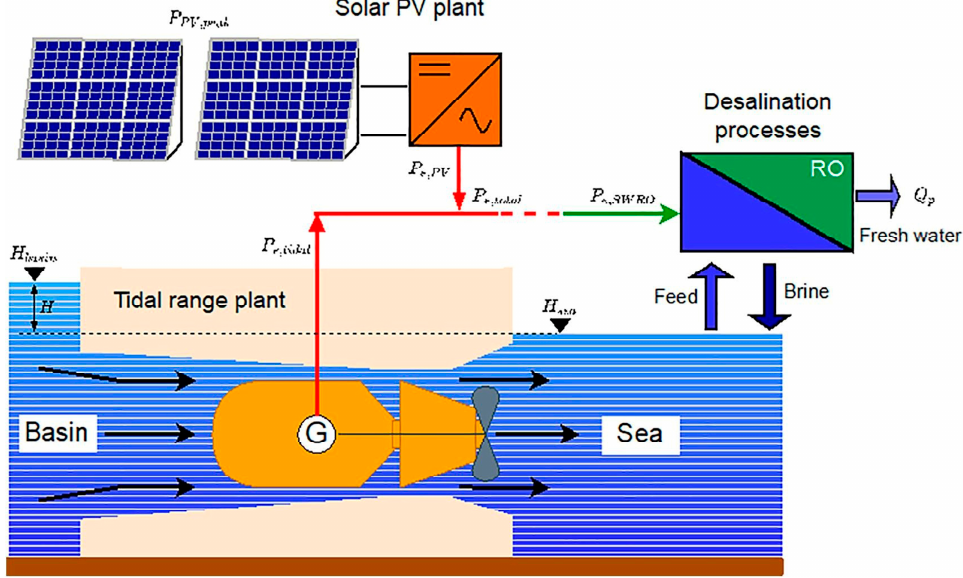
Figure 14. Hybrid tidal/ PV-WDS [136], open access article distributed under the terms of the Crea- tive Commons CC-BY